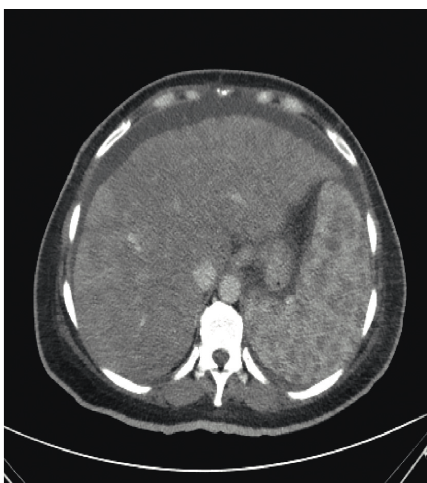
Figure 3: Computed tomography of the abdomen with contrast showing hepatosplenomegaly, numerous hypodensities in the spleen and ascites.